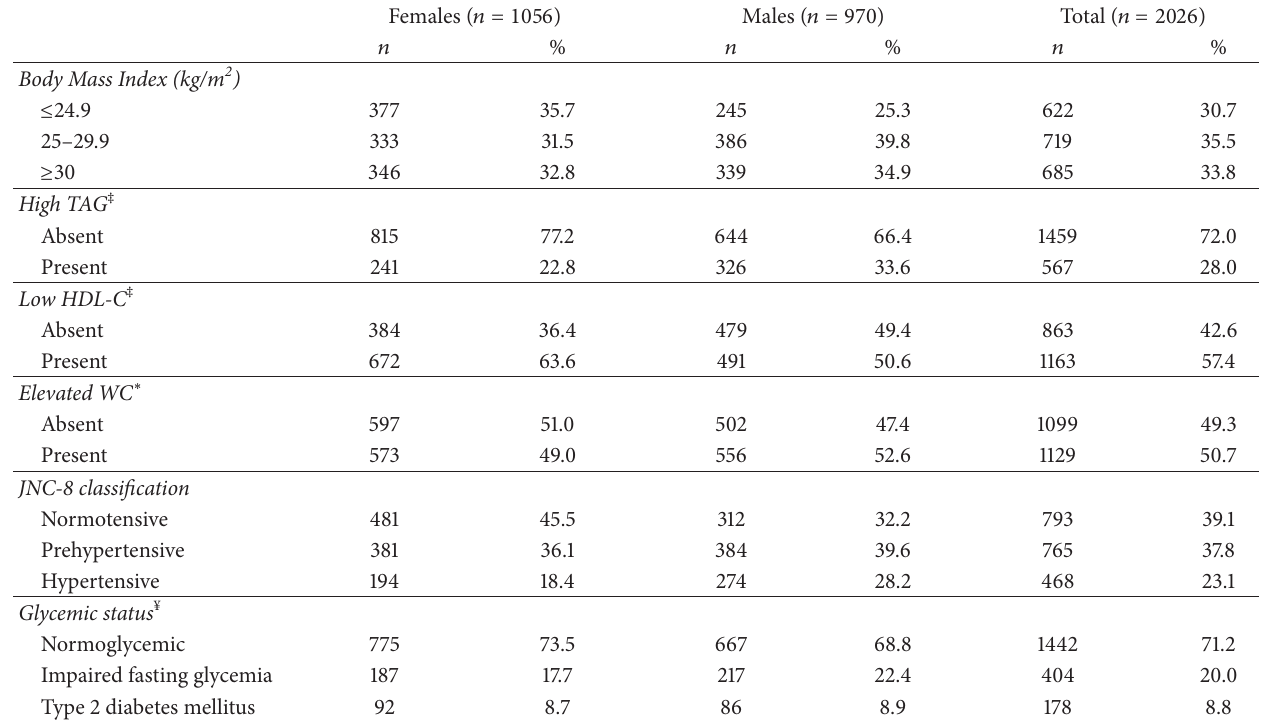
Table 3: Anthropometric and cardiometabolic characteristics of the population by gender (Maracaibo, Venezuela,